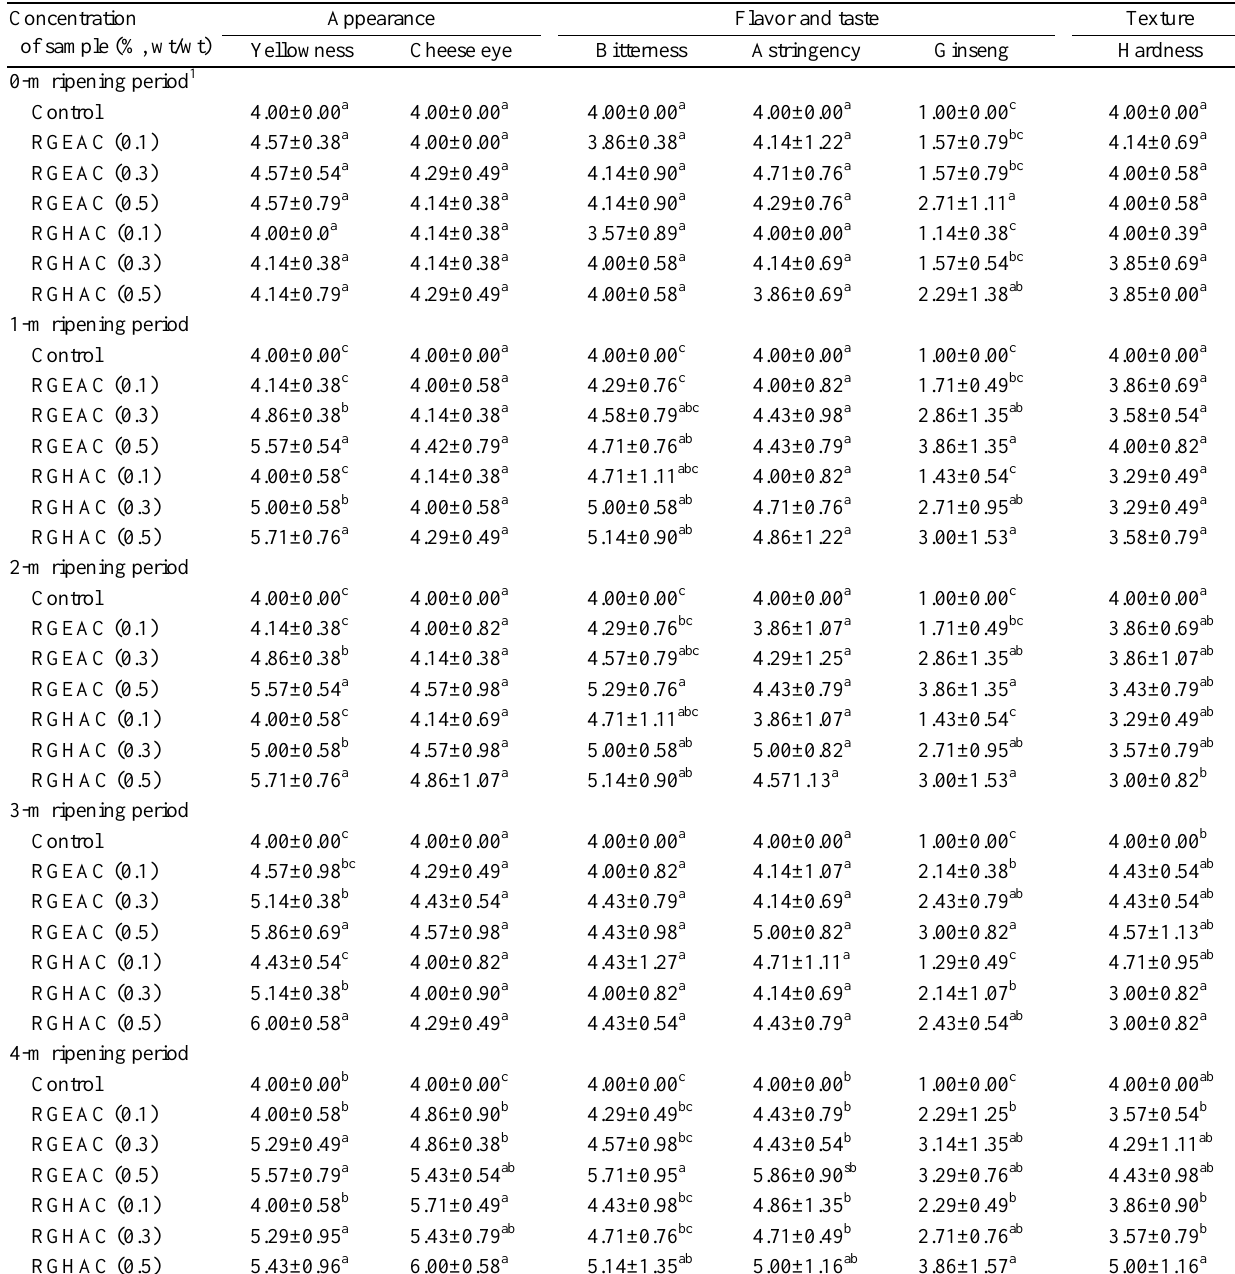
Table 6. Sensory evaluation of the red ginseng hydrolyzate- or red ginseng extracts-added Asiago cheese ripened at 14°C for 4 months Concentration of sample (%,